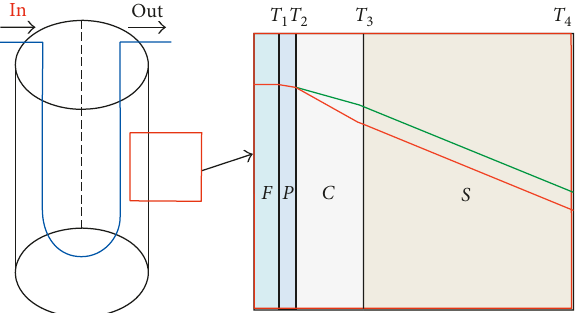
Figure 2: Heat transfer schematic of energy pile and heat transfer curves for original (red) and enhanced (green) concrete heat transfer (in